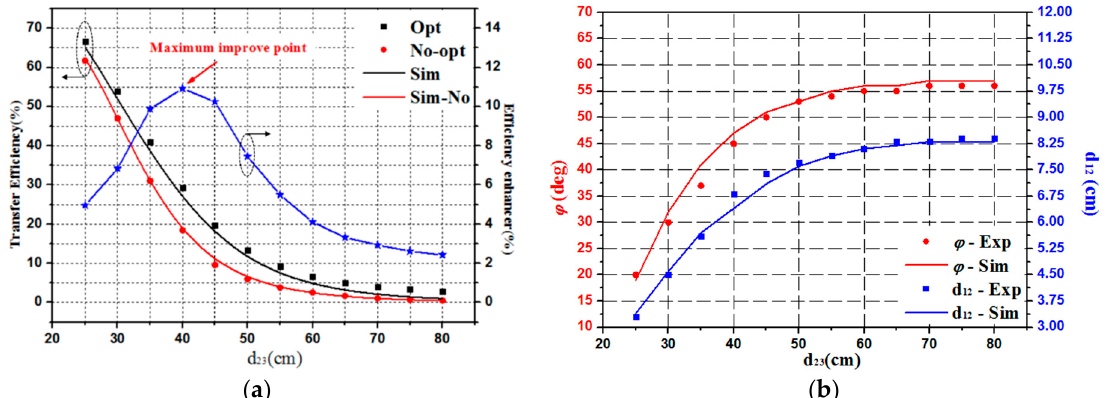
Figure 11. ( a ) Maximum transfer efficiency at various transmission distances, ( b ) Optimal d 12 and φ at various transmission distance s.